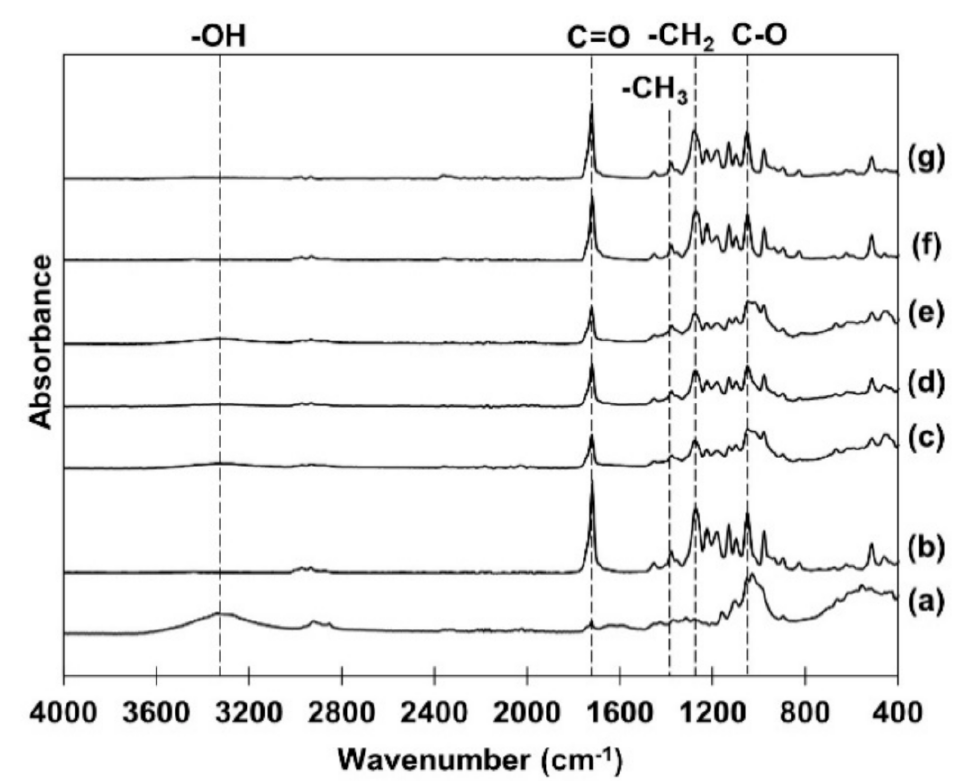
Figure 3. FTIR spectra of ( a ) non-coated PLFP, ( b ) commercial P(3-HB) film, ( c – e ) commercial P(3-HB) coated PLFPs at 5%, 7.5% and 10% ( w/v ), ( f ) biosynthesized P(3-HB) film and ( g ) biosynthesized P(3-HB) coated PLFP at 7.5% ( w/v